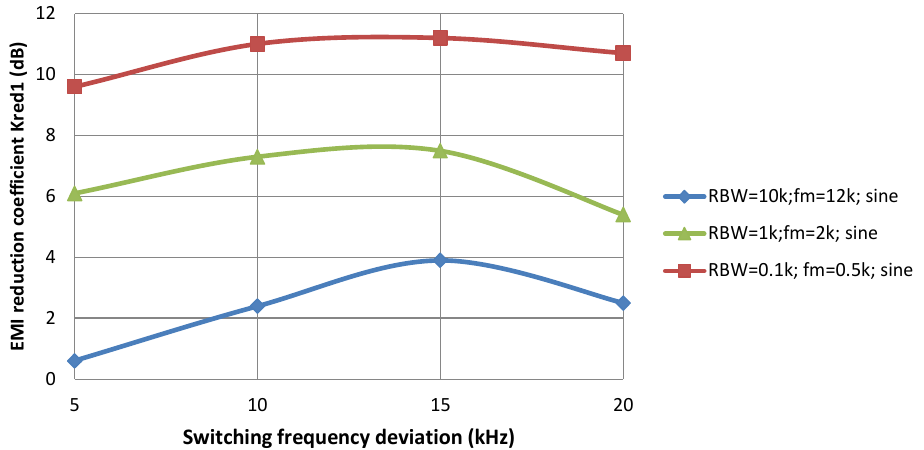
Figure 11. K red versus f m when periodic SFM (with different modulation waveforms and Δ f peak = 12 kHz) is used.